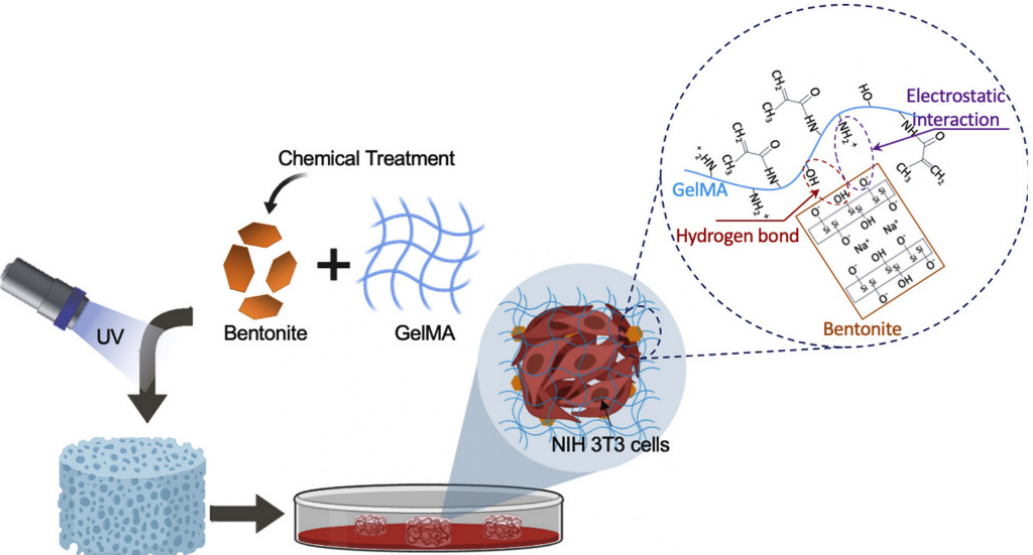
Figure 7 . Schematic representation of bentonite-GelMA fabrication with NIH 3T3 fibroblast cells. (Reprinted with permission from [49]. Copyright 2020, Elsevier) .